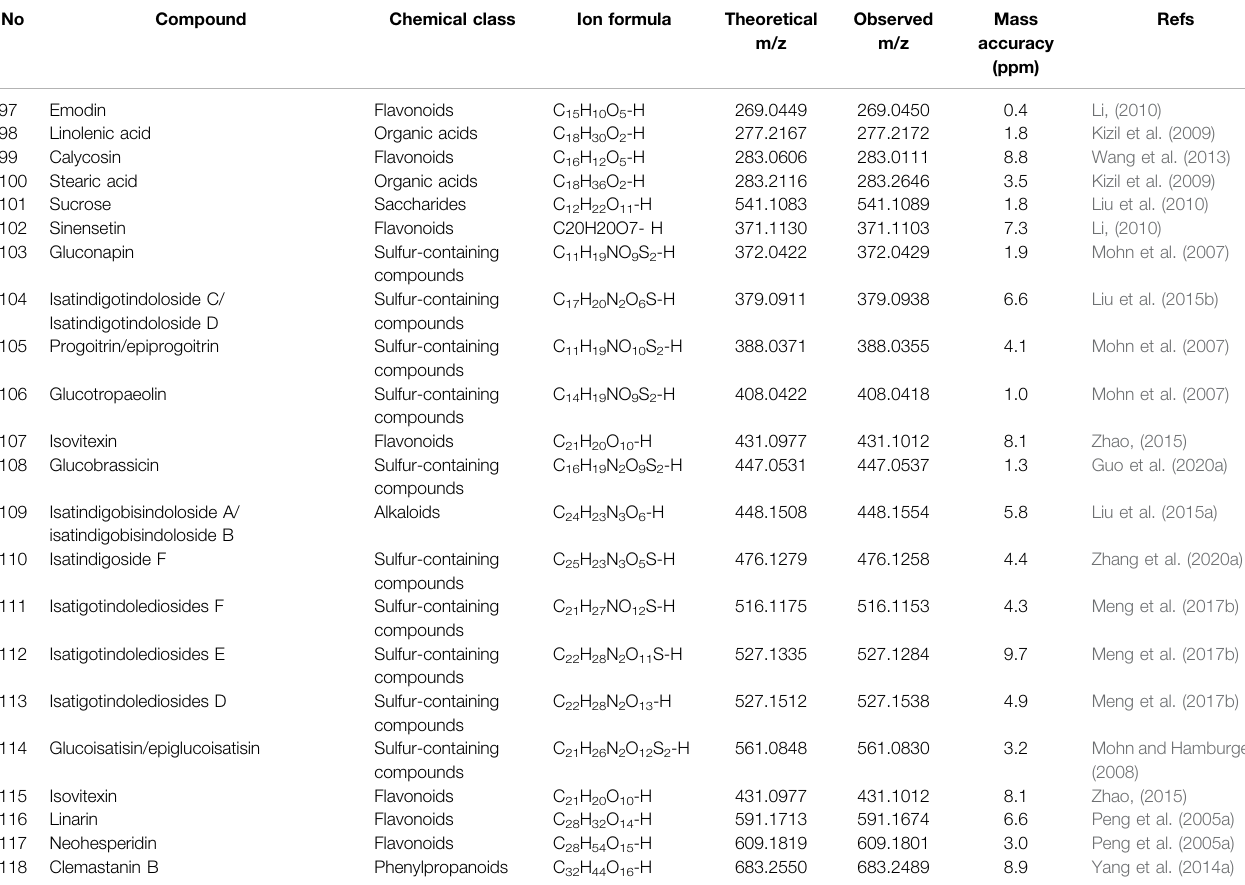
TABLE 2 | ( Continued ) Assignment of ions observed in the matrix-assisted laser desorption and ion trap – time-of- fl ight (MALDI-IT-TOF) mass spectrometry imaging (MSI) of the dried root of Isatis indigotica with references regarding shown